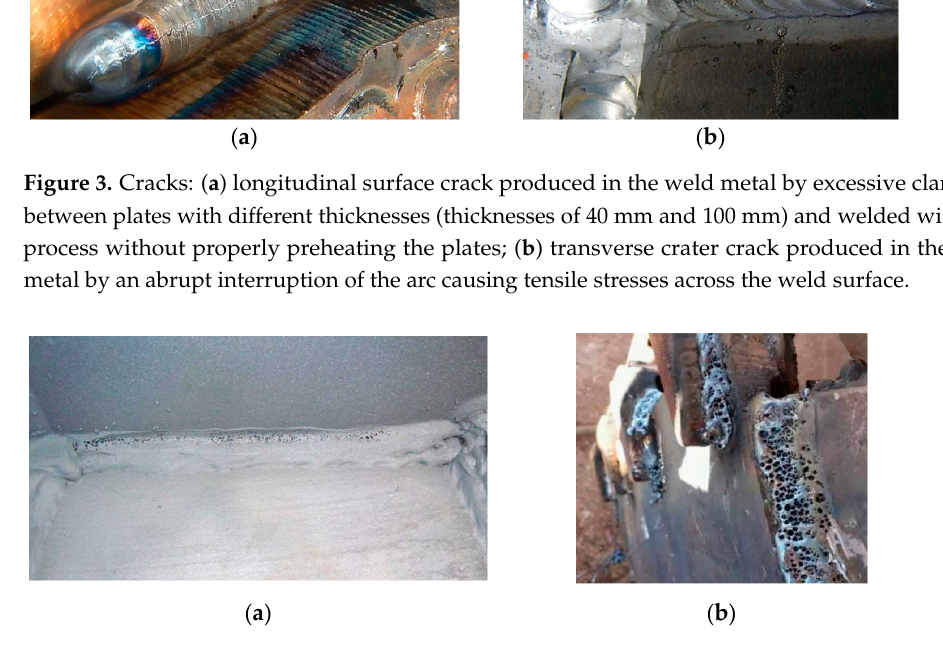
Figure 5. Undercuts caused by using a higher current than necessary ( a,b ).